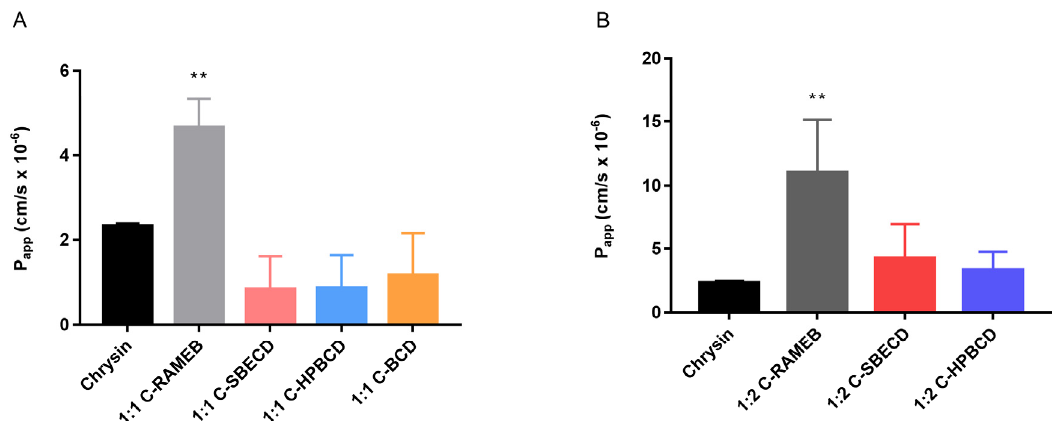
Figure 5. Permeability of chrysin on Caco-2 monolayers treated with 1:1 ( A ) and 1:2 ( B ) chrysin– cyclodextrin complexes. RAMEB significantly increased P app of chrysin both at 1:1 and 1:2 molar ratios (data are presented as means ± SD, p < 0.01, n = 3) (P app —apparent permeability coefficient).